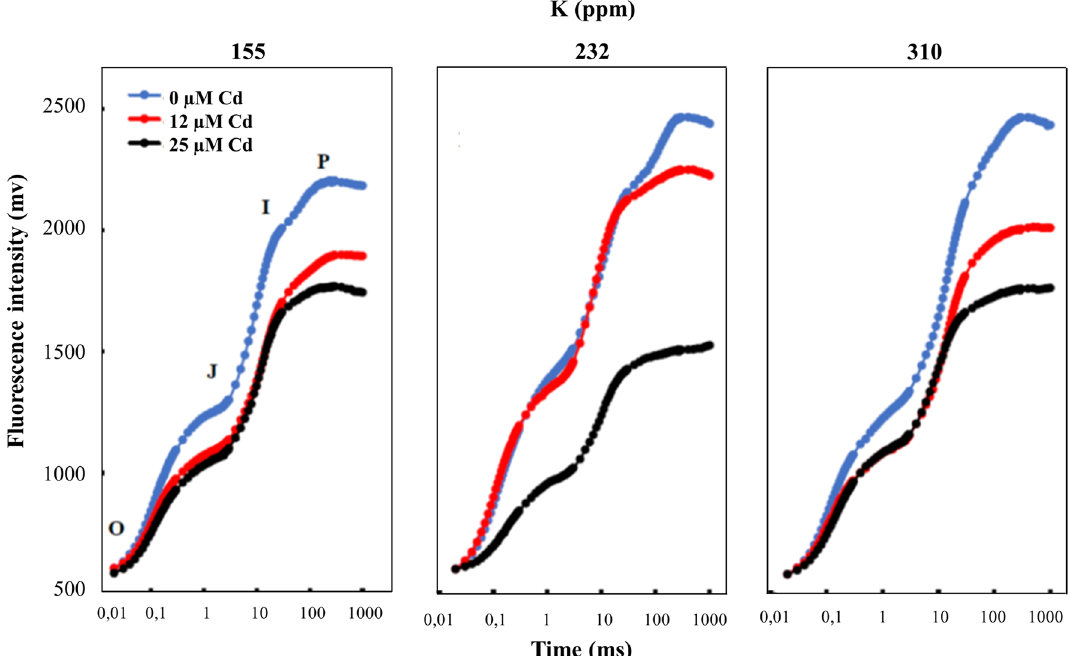
Figure 5. Effects of potassium concentration (155, 232, and 310 ppm) and three cadmium concentrations (0, 12 and 25 µM CdCl 2 ) on Chlorophyll a fluorescence transient curve of tomato plants. Each value represents the mean ± SD of six independent repetitions, dissimilar letters indicate significant differences at p < 0.05 according to Student–Newman–Keuls